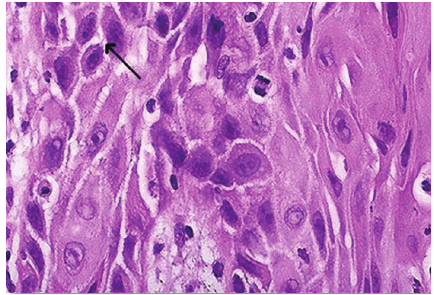
Figure 3: Photomicrograph (H & E stain 20x).